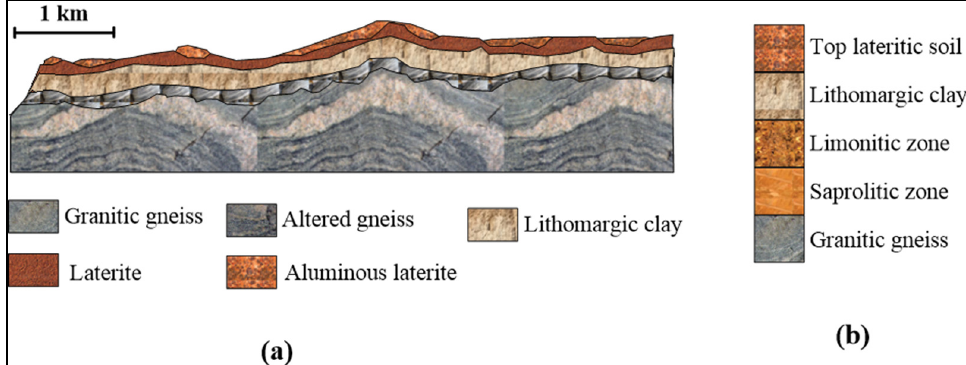
Figure 1. Soil strati fi cation, ( a ) laterization on soil made up of gneissic granites ( b ) showing di ff erent zones of the laterite pro fi le.